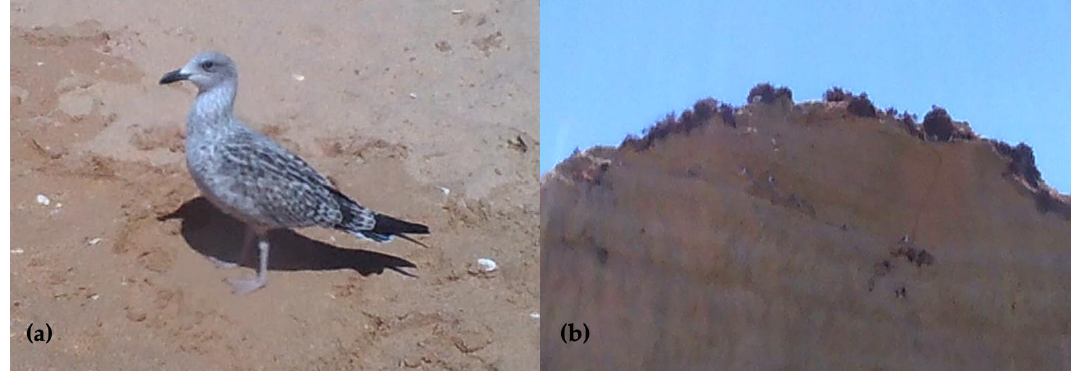
Figure 6. ( a ) Juvenile specimen of Larus michahellis (Naumann, 1840). ( b ) Nesting areas in the cliffs.